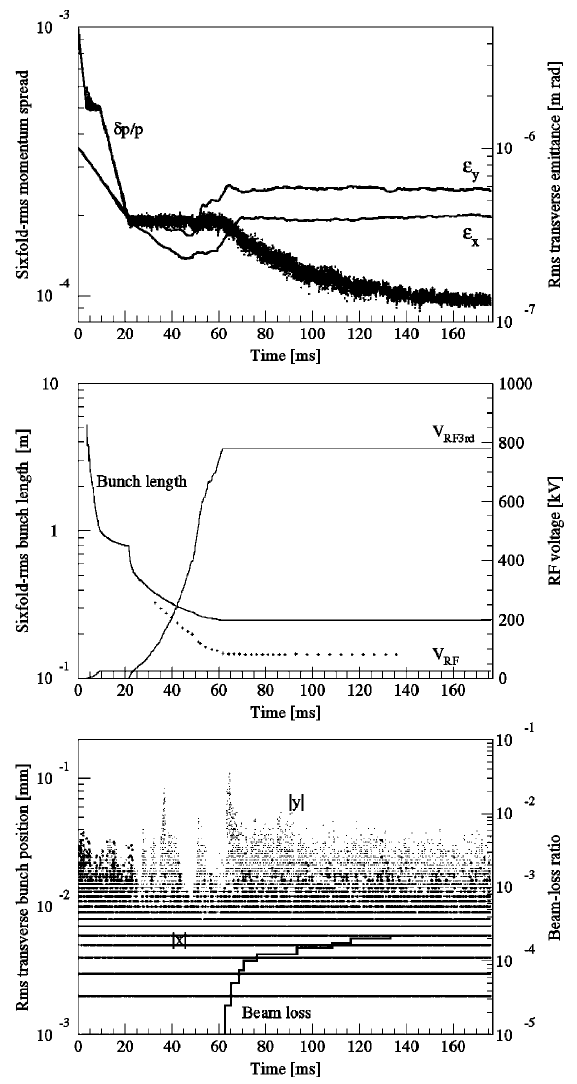
FIG. 7. Time evolution of the beam under the resonance control. In the middle panel the dotted curve indicates the sixfold-rms bunch length without counting ions at z (cid:2) (cid:15) 1 m .